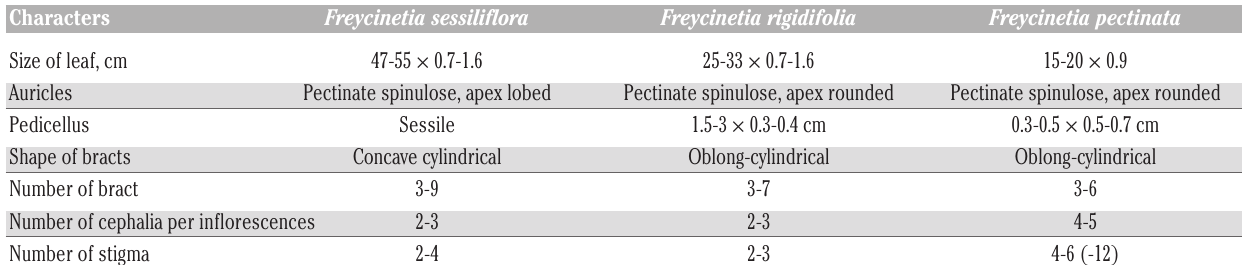
Table 1. Morphological differences between Freycinetia sessiliflora, Freycinetia rigidifolia, and Freycinetia pectinata